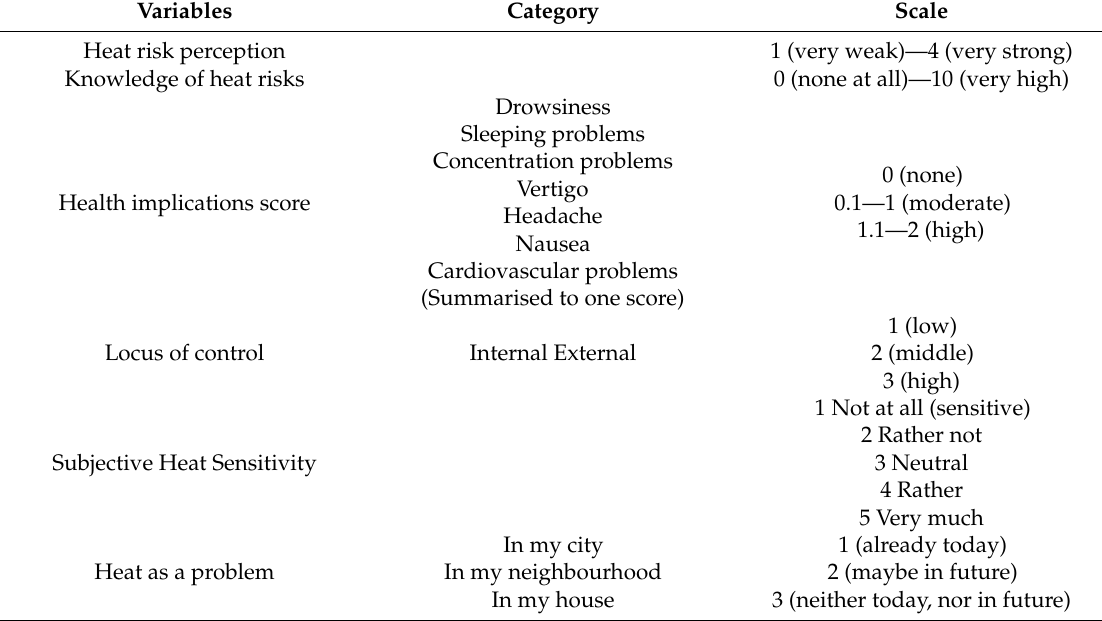
Table 2. Variables and scores included in the data